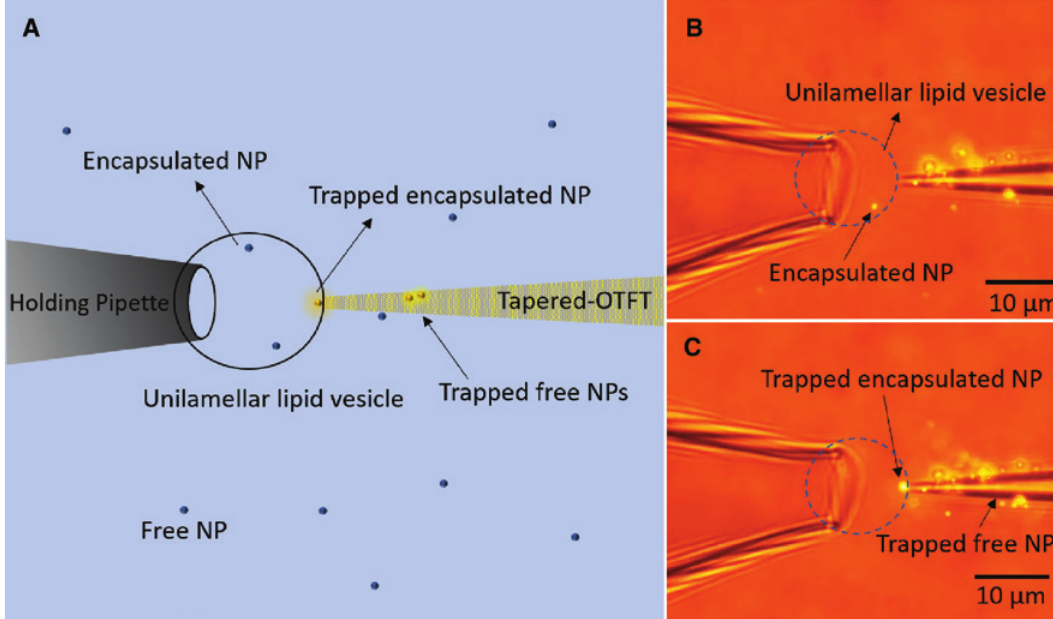
Figure 6: Trapping of nanoparticle encapsulated inside lipid vesicle. (A) Schematic of the tapered OTFT used for trapping 200 nm fluorescent nanoparticle encapsulated in a large unilamellar lipid vesicle. (B) Microscope image showing the tapered OTFT (parallel mode) in contact with the membrane of the lipid vesicle. The arrow pointing to the bright spot indicates the 200 nm fluorescent nanoparticle (NP) encapsulated inside the immobilized lipid vesicle. (C) Microscope image showing the trapping of encapsulated nanoparticle at the tip of the tapered